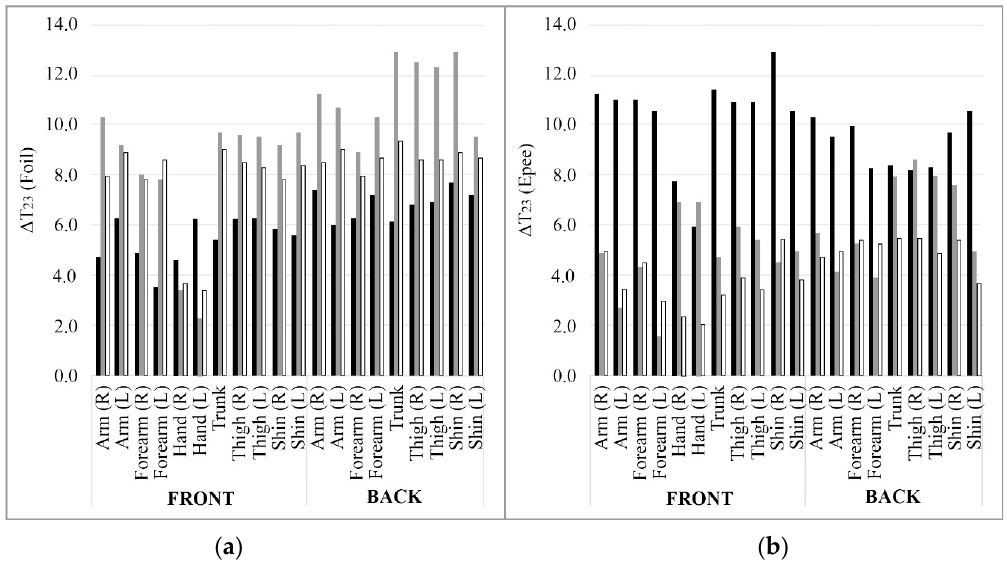
Figure 4. Temperature difference Δ T 23 on the front and the back part of the body for foil ( a ) and epee ( b ) fencers. In black veteran fencers (ID 4 for foil, ID 7 for epee), in grey national fencers (ID 3 for foil, ID 5 for epee) and in white international fencers (ID 1 for foil, ID 8 for epee).